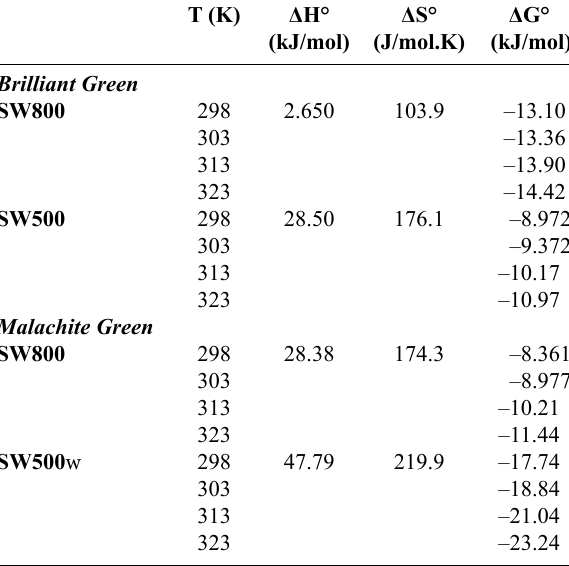
Table 1. Thermodynamic parameters for adsorption of BG and MG onto SW500 and SW800 (n =